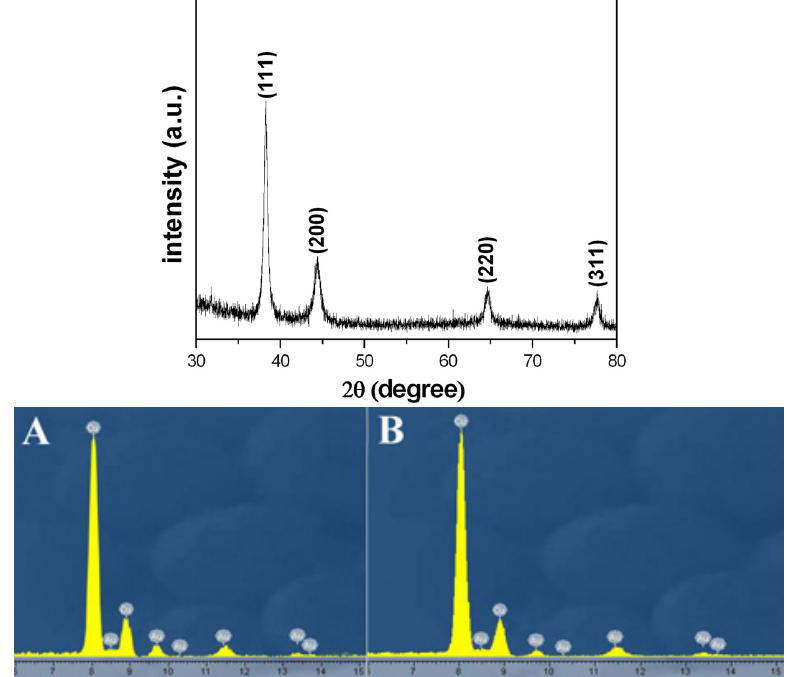
Figure 3. XRD pattern of gold nanoboots and EDX spectra of gold nanohexagons (A) and nanoboots